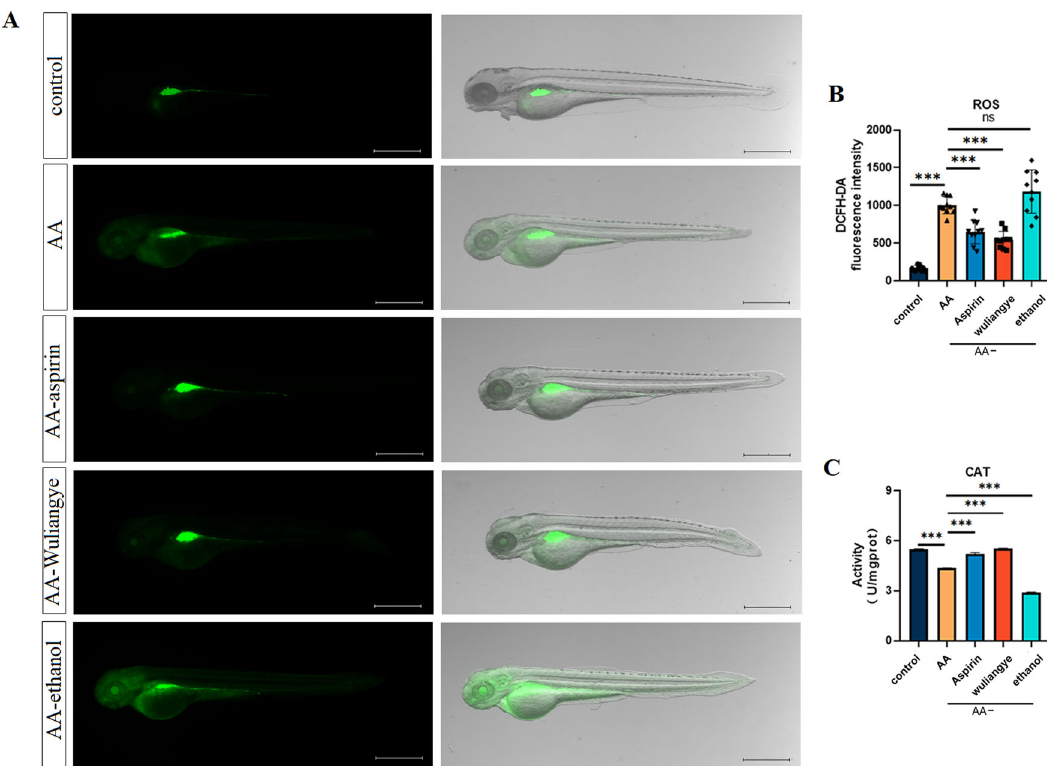
Fig. 2 Wuliangye reduces the elevated levels of oxidative stress in the zebra fi sh thrombosis model. Representative images ( A ) and quanti fi cation ( B ) of the fl uorescence signals of DCFH-DA staining in different treatment groups ( n = 10). Concentration of CAT ( C ) in zebra fi sh in different treatment groups. Scale bar = 500 μ m. Compared with the control group; compared with the model group; data are presented as mean ± standard deviation (ns for not signi fi cant, *** P < 0.001, t